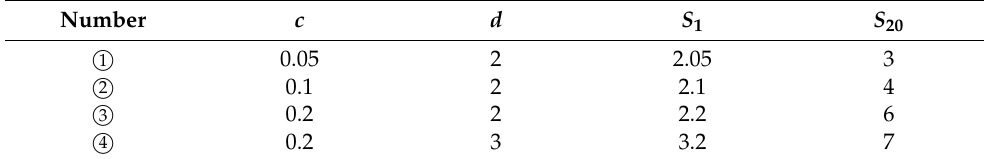
Table 4. The assignment of c , d for the increasing trends.